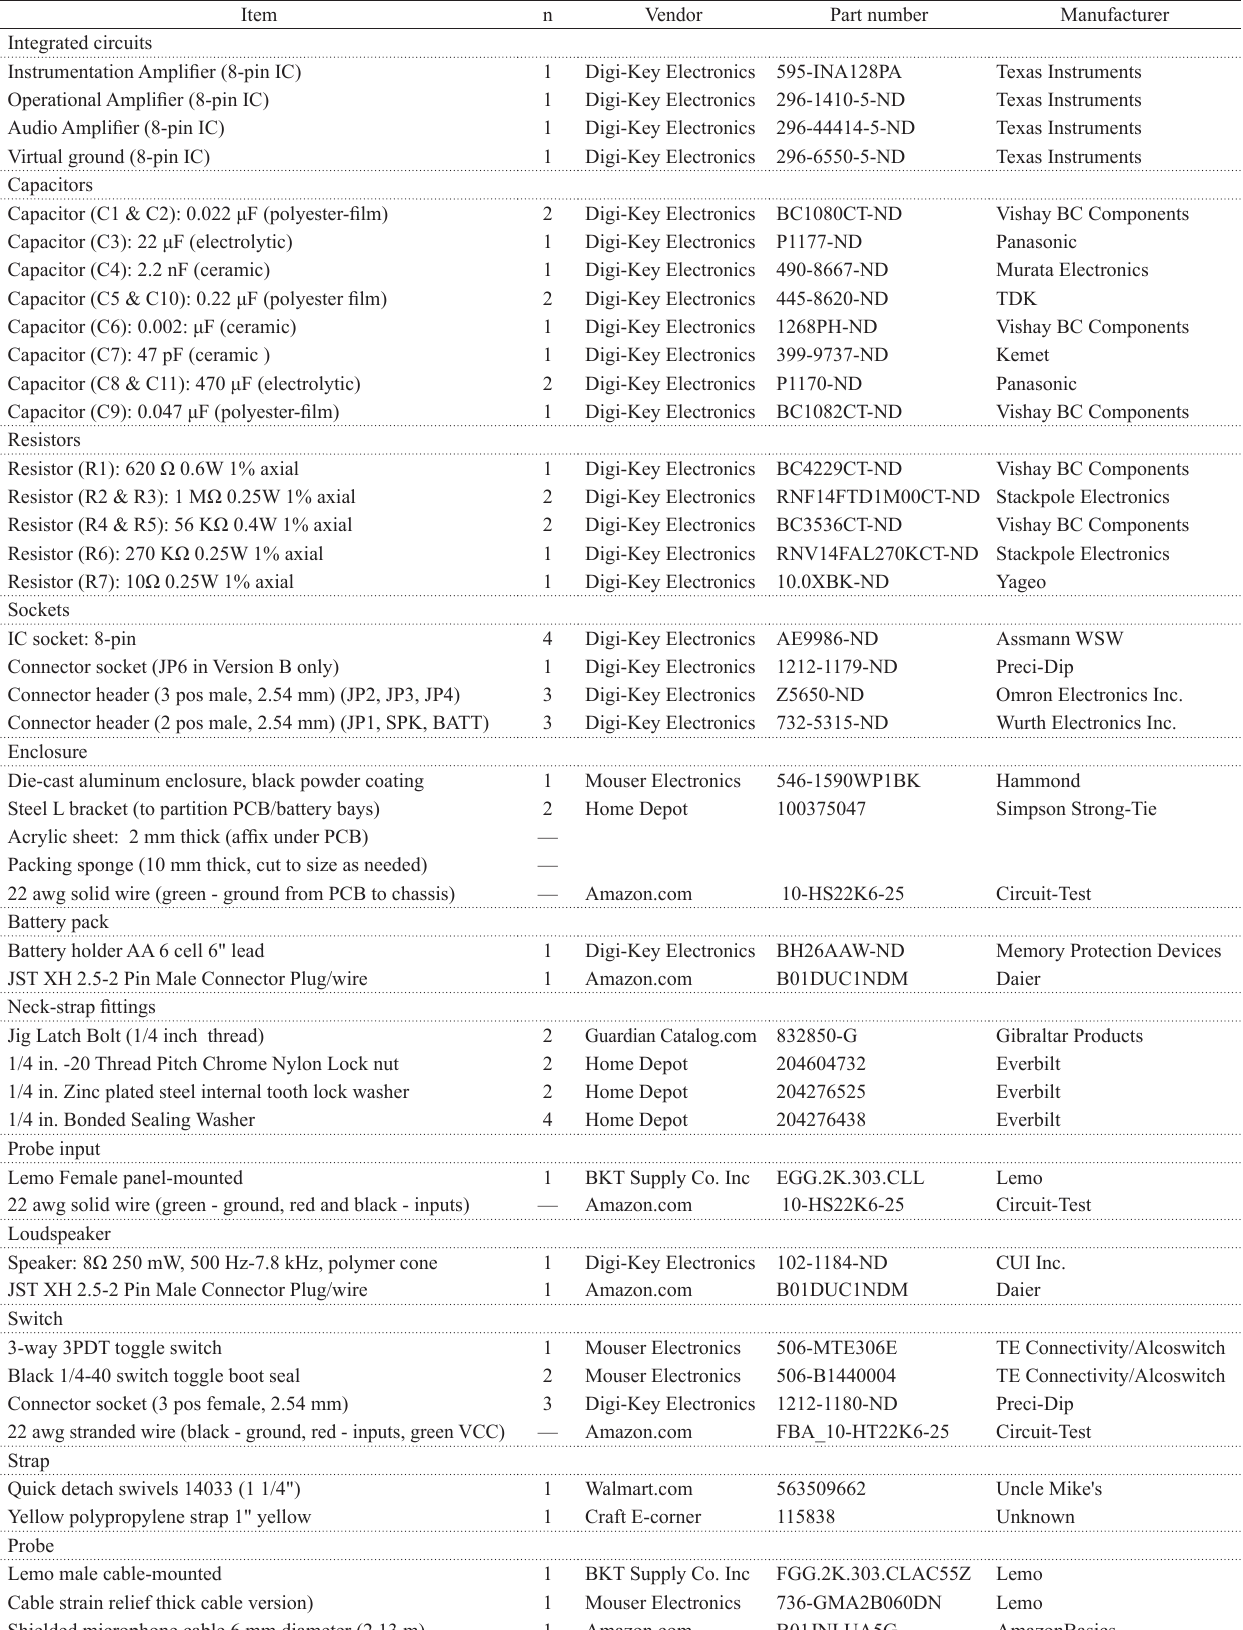
Tab. 1. Electric fish finder component list. n = number required per